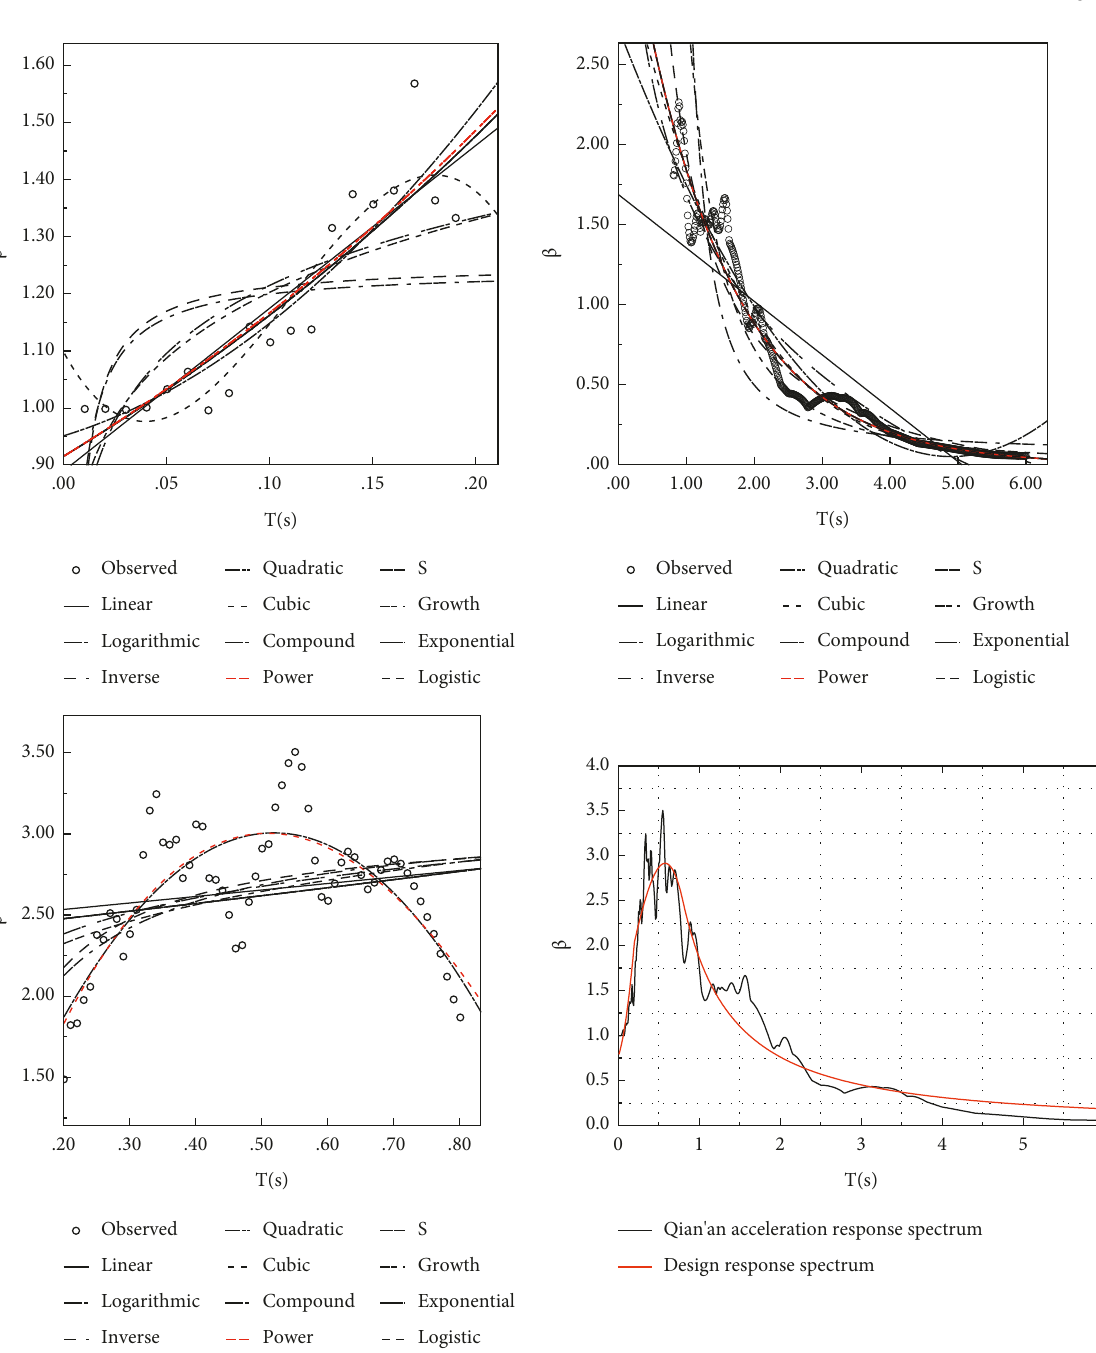
Figure 5: Schematic diagram of segmental fitting of the Qian’a dynamic amplification coefficient spectrum.